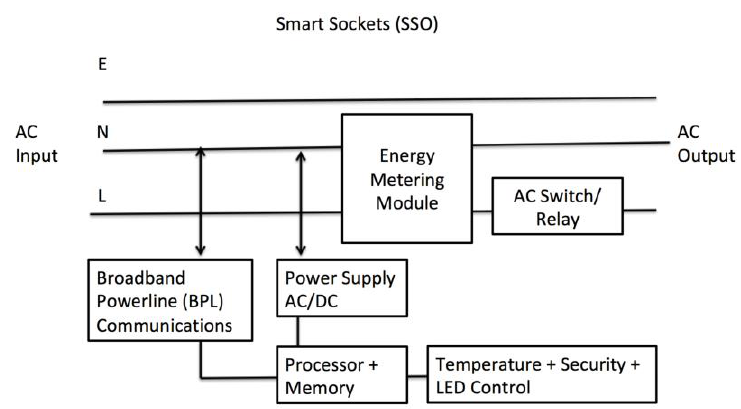
Figure 14. Smart Sockets with built-in temperature sensors. Relay and broadband powerline (BPL) communications.